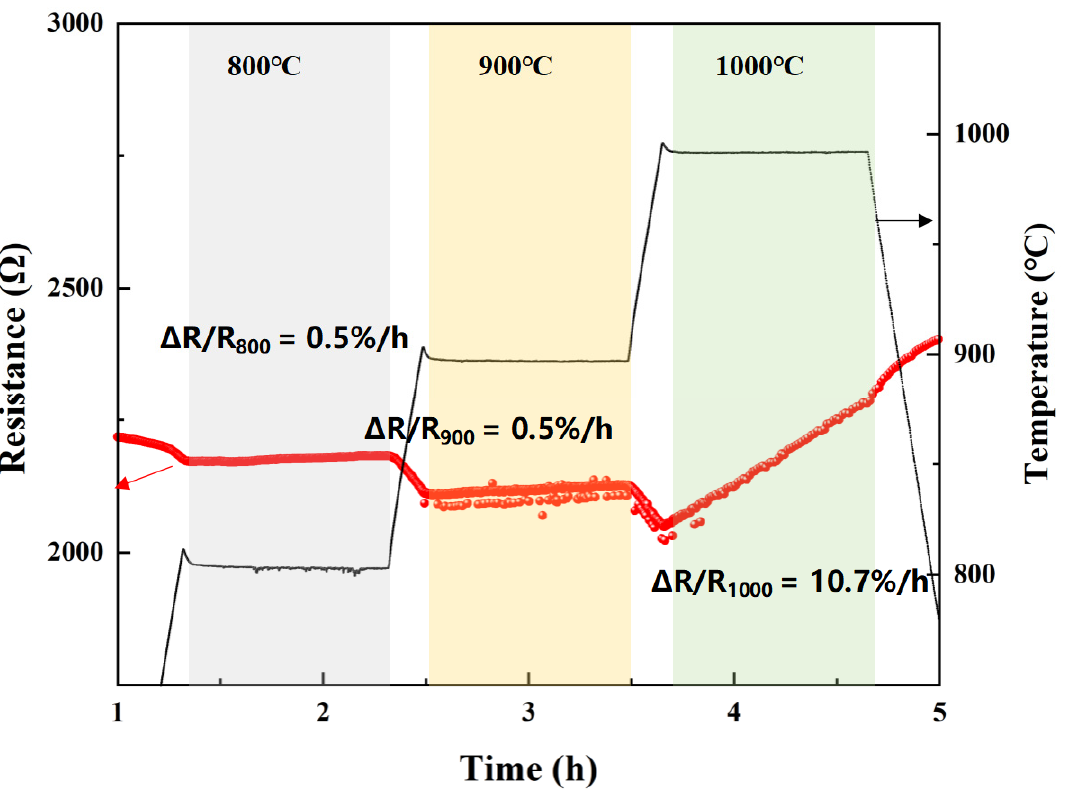
Figure 7. Resistance change curves of TiB 2 /SiCN resistive grid with Al 2 O 3 (20 wt%)/SiCN protective layer at 800 °C, 900 °C, and 1000 °C for 1 h.